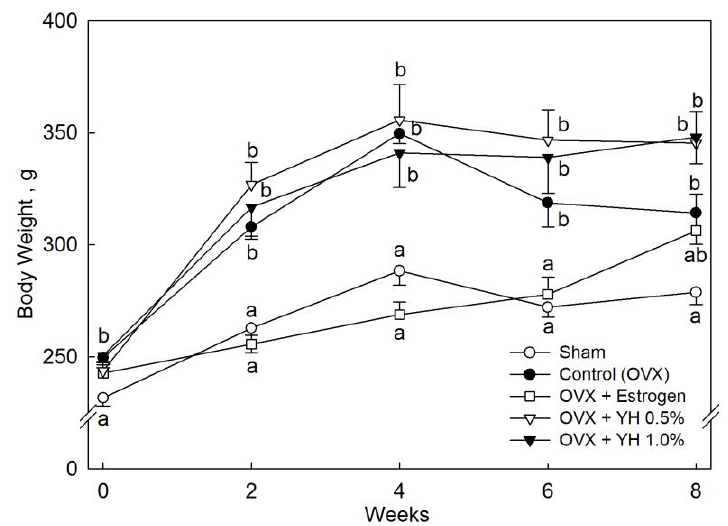
Figure 1. Body weight of ovariectomized (OVX) rats treated with yeast hydrolysate (YH) for 8 weeks. The data are presented as mean ± SEM for seven rats. According to Tukey’s multiple range tests, means with different superscript letters are significantly different ( p < 0.05). Sham: sham operation; Control: no treatment after OVX; Estrogen: estrogen treatment after OVX; YH, 0.5%: drinking water supplementation with 0.5% YH after OVX; YH, 1%: drinking water supplementation with 1% YH after OVX. YH 0.5% and 1% in drinking water are equivalent to a dose of 1 and 2 g · kg − 1 BW, respectively, based on daily water consumption.